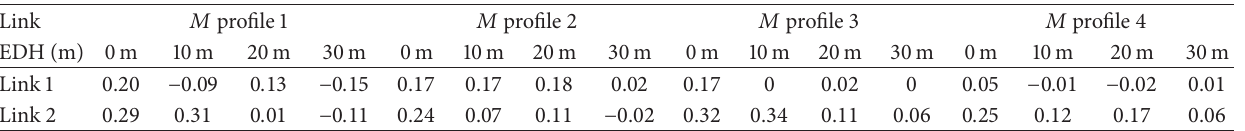
Table 4: Annual correlation coefficients for all the communication links and 𝑀 profiles for (a) EDH 0 m, (b) EDH 10 m, (c) EDH 20 m, and (d) EDH 30 m. EDH is the evaporation duct height.